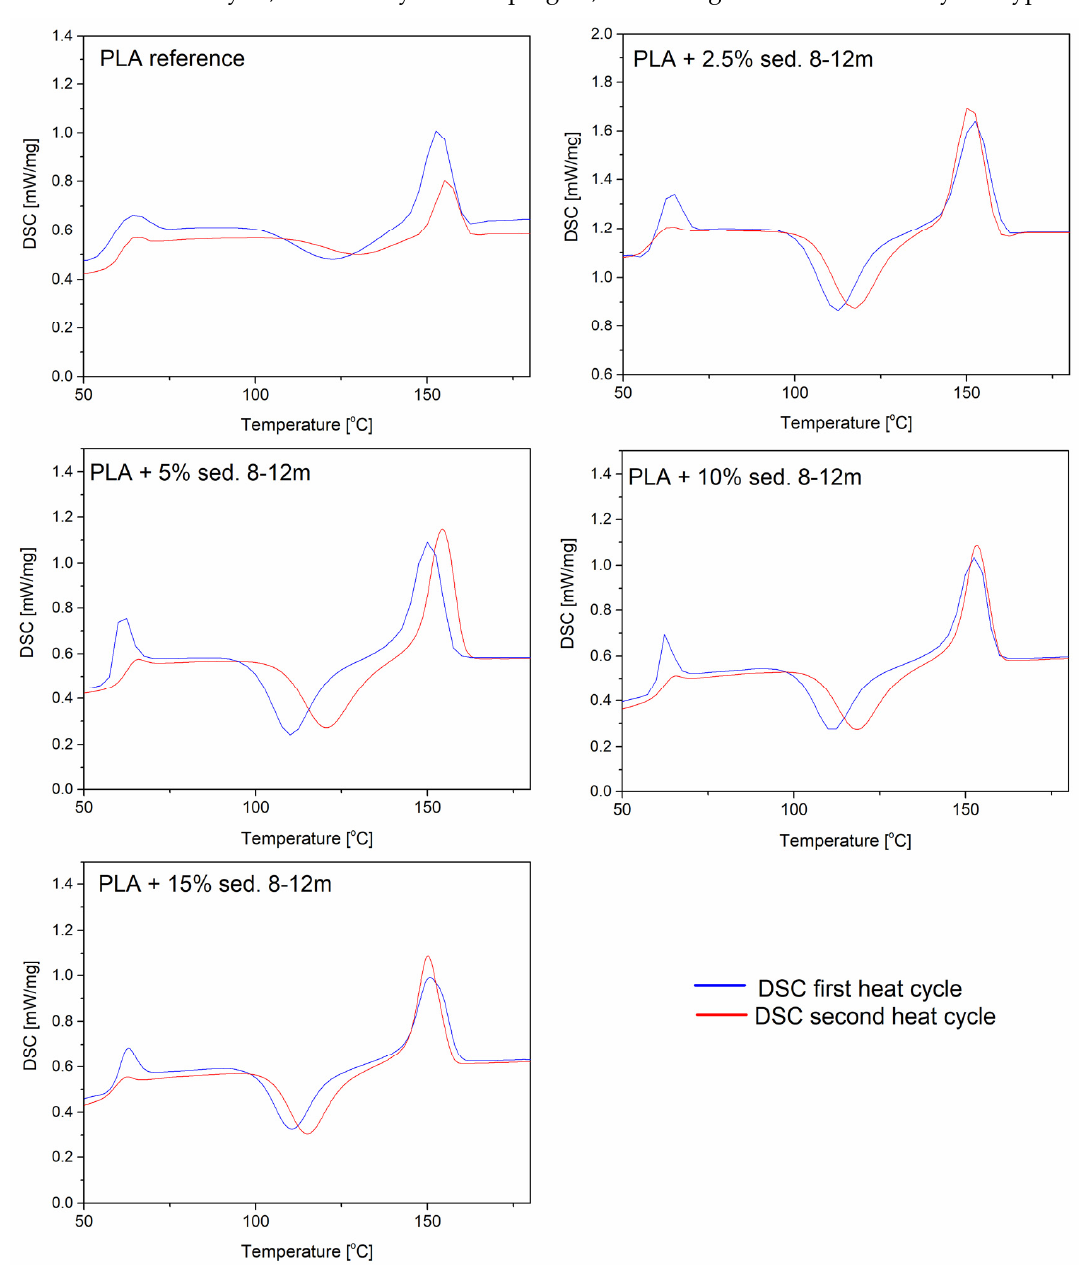
Figure 8. DSC plots of PLA/sedB.